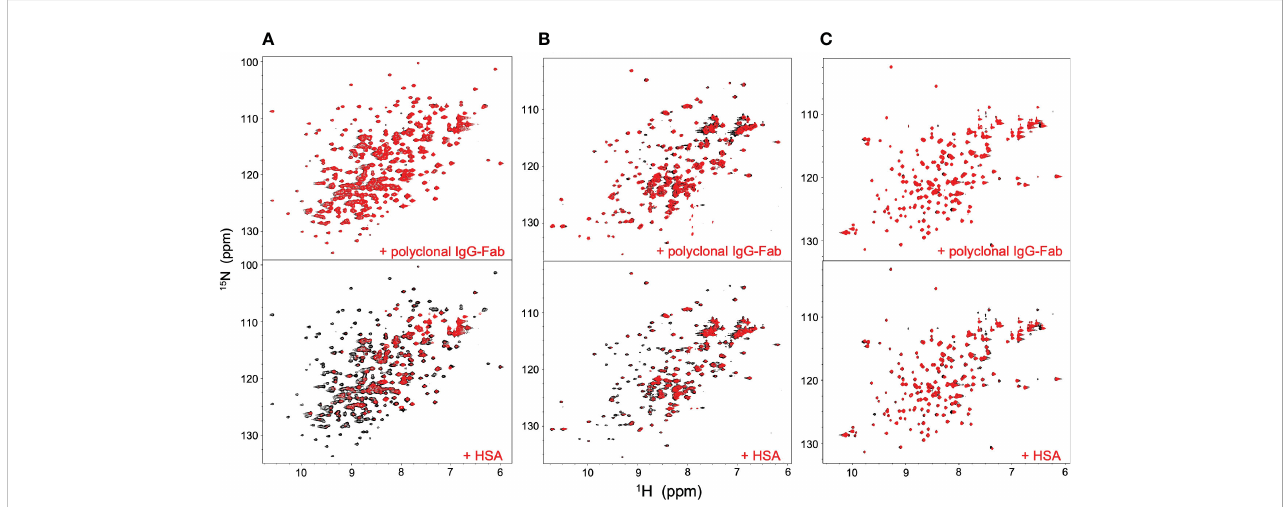
FIGURE 3 HSQC spectral changes of rituximab-Fc, rituximab-Fab, and sFc g RIIIb induced by the serum components. HSQC spectra of uniformly 15 N-labeled rituximab- Fab (A) , rituximab-Fc (B) , and sFc g RIIIb (C) were measured in the absence (black) or presence (red) of HSA (lower) or polyclonal IgG-Fab (upper).